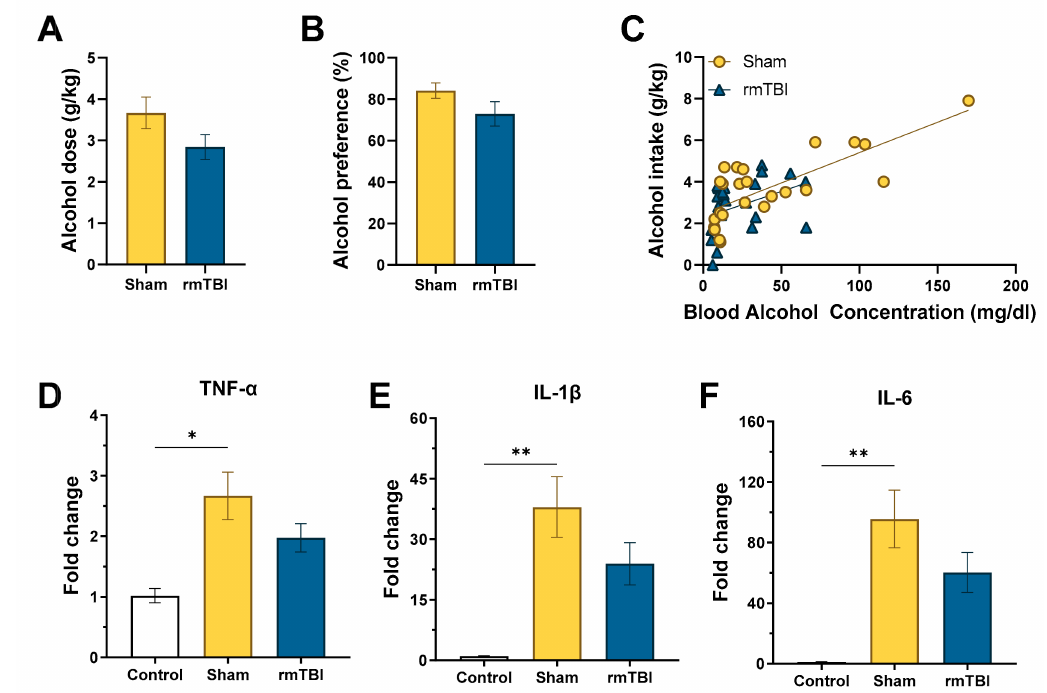
Figure 2. Alcohol drinking resulted in increased cytokine expression: ( A ) alcohol intake and ( B ) preference ( n = 12 / group), did not di ff er as a result of rmTBI ( C ) and BAC (mg / dL), ( n = 24 / group); ( D ) tumor necrosis factor (TNF)- α (control n = 4, sham n = 10, rmTBI n = 9), ( E ) interleukin (IL)-1 β (control n = 3, sham n = 5, rmTBI n = 6), ( F ) and IL-6 (control n = 3, sham n = 5, rmTBI n = 6) all showed pronounced increase of expression following 2 weeks of alcohol